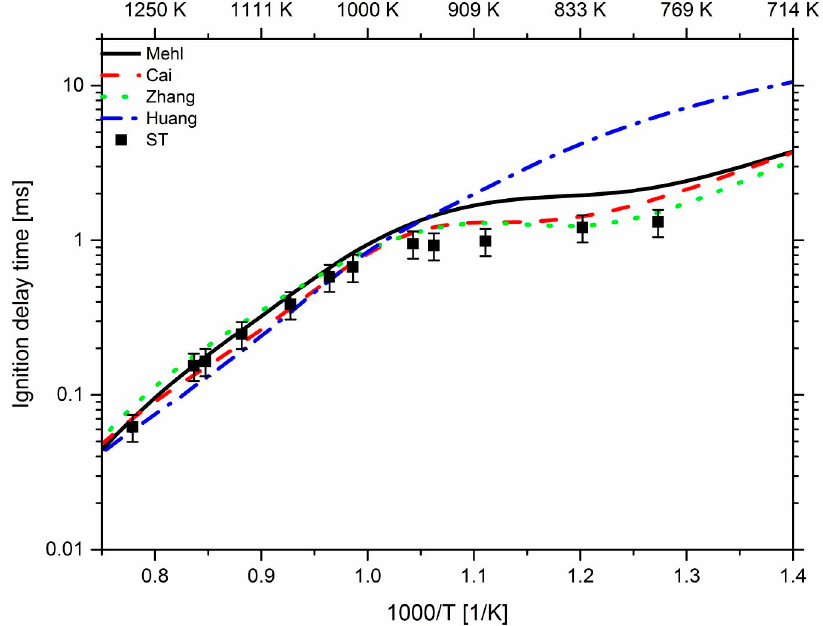
Figure 11. Experimental ST data (symbols) versus model prediction at P c = 60 bar using 95 mol % CH 4 ,